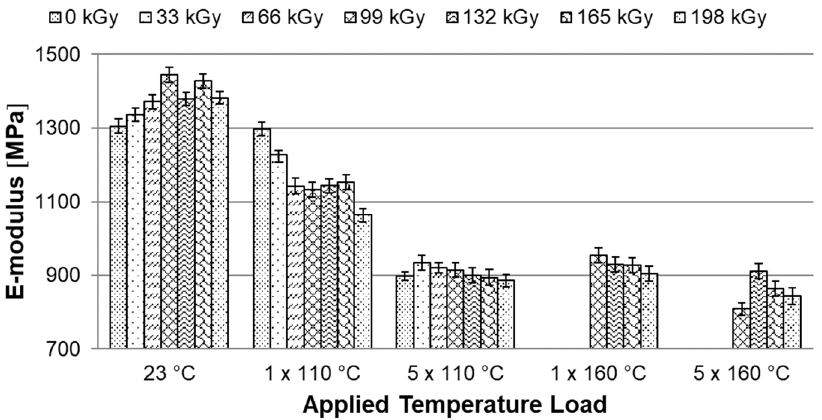
Figure 10. Dependence of E-modulus on applied temperature load.